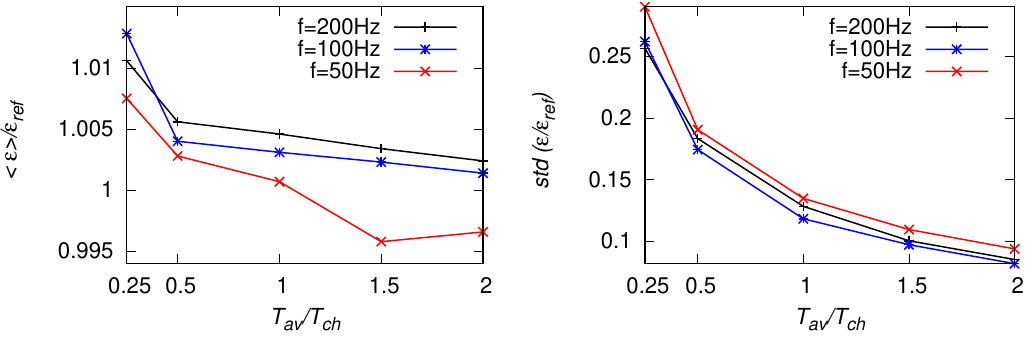
Figure 10. Statistics of (cid:101) SF estimates based on the second-order structure function, Equation (7), for the fitting range f = [ 10 ÷ 20 ] Hz, from artificial signals with f s = 200 Hz, 100 Hz and 50 Hz. Left panel : EDR averaged along the signal, right panel : standard deviation of the estimates.